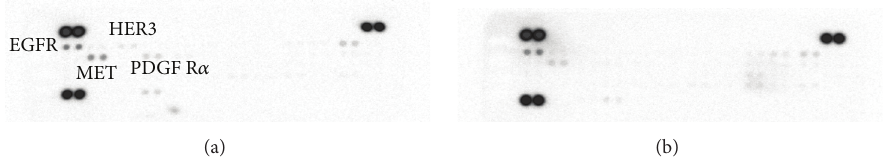
Figure 2: Human Phospho-Receptor Tyrosine Kinase (RTK) Array blots. The activated RTKs are determined in human telomerised stromal stem cell lines (hMSC-TERT). (a) hMSC-TERT4, nontumorigenic. (b) hMSC-TERT20-CE8 a clonal cell line with the ability to form sarcoma- like tumours in mice. The activated tyrosine kinases are represented by black dots on the membranes. For quantification data of the membranes, see supplementary Figure 2 in Supplementary Material available online at